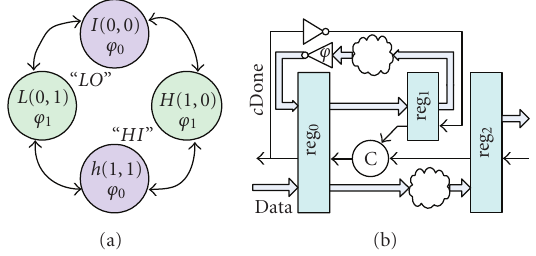
Figure 3: LEDR coding (a) and exemplary LEDR circuit structure